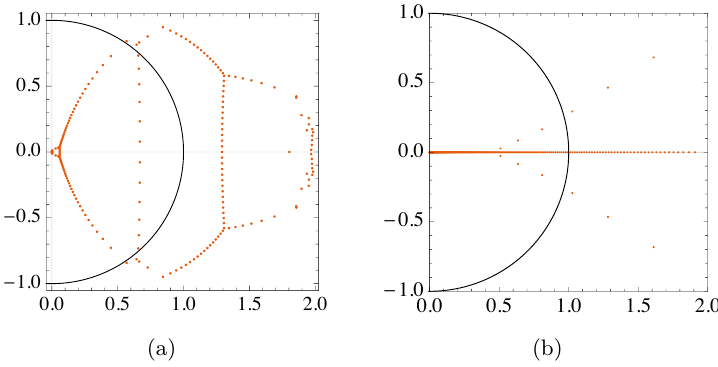
Figure 5 . Eigenvalues of the Jacobian in the complex plane for a pure CDD-pole amplitude for = 2 . 8 : a) linear interpolation; b) interpolation with Bernstein m 2 p